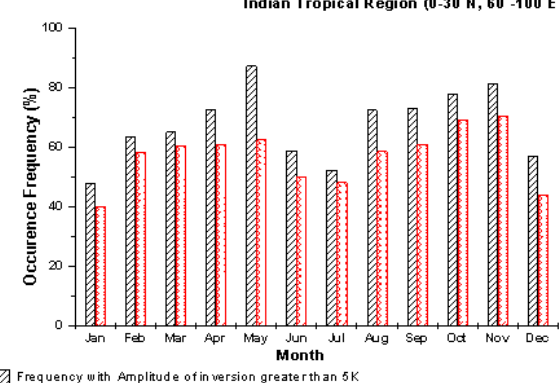
Fig. 2. Averaged monthly variation of the frequency of occurrence (%) as obtained in this work using the HALOE temperature series over the Indian tropical region (0–30 ◦ N, 60–100 ◦ E) during the pe- riod 1991–2001. For the two cases 1) occurrence frequency calcu- lated by considering the days with amplitude of inversion greater than 5K and 2) occurrence frequency calculated by considering the days with amplitude of inversion greater than